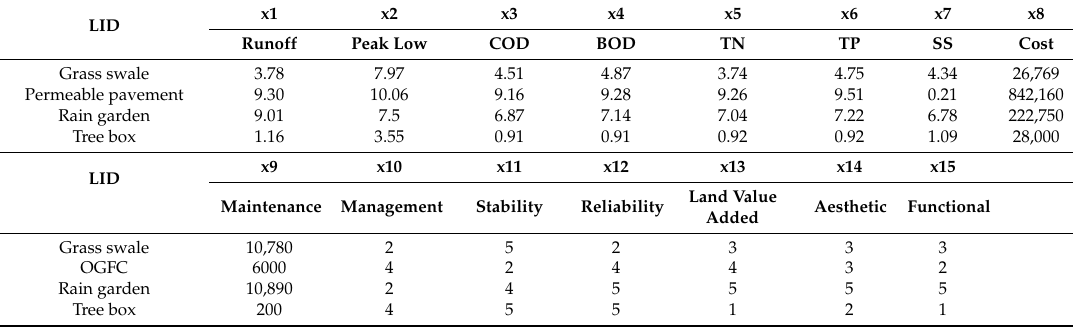
Table 5. Performance indicator of LCTIP.